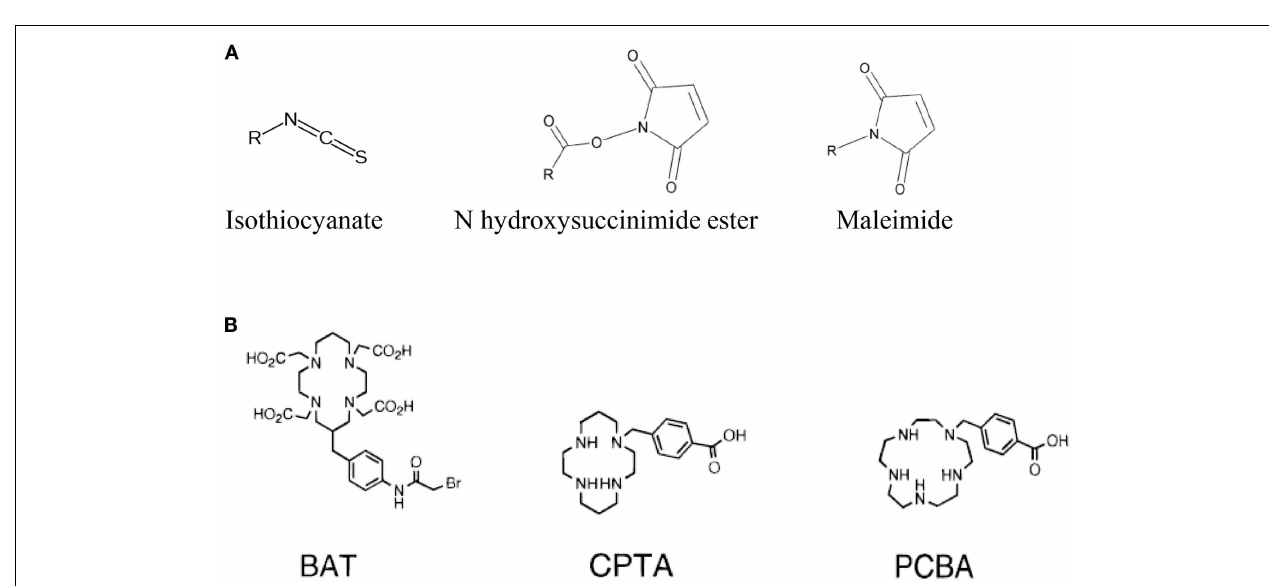
conjugated to peptide using the linking agent 2IT (2-iminothiolane) which forms a thioether bond between BAT and the peptide. CPTA and PCBA are conjugated to peptide via an amide linkage. Adapted from Rogers et al.